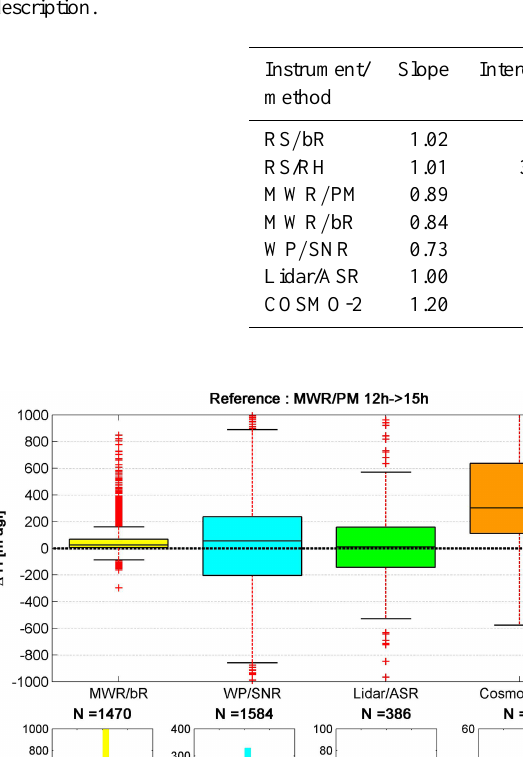
Table 3. Linear regression of PBL height computed with various methods and instruments as a function of RS / PM. See Table 2 for parameters description.